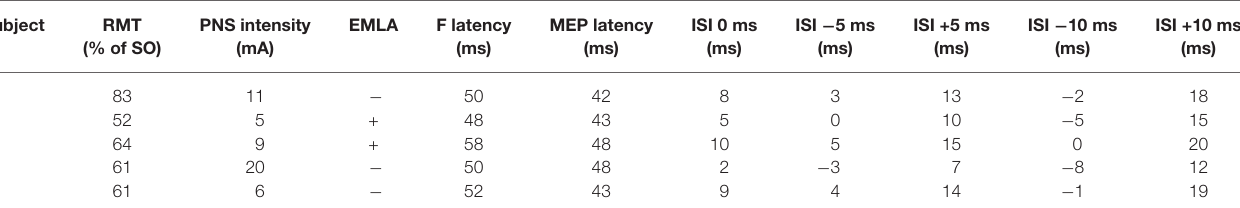
averaged using MATLAB (MathWorks Ltd., Nattick, MA,